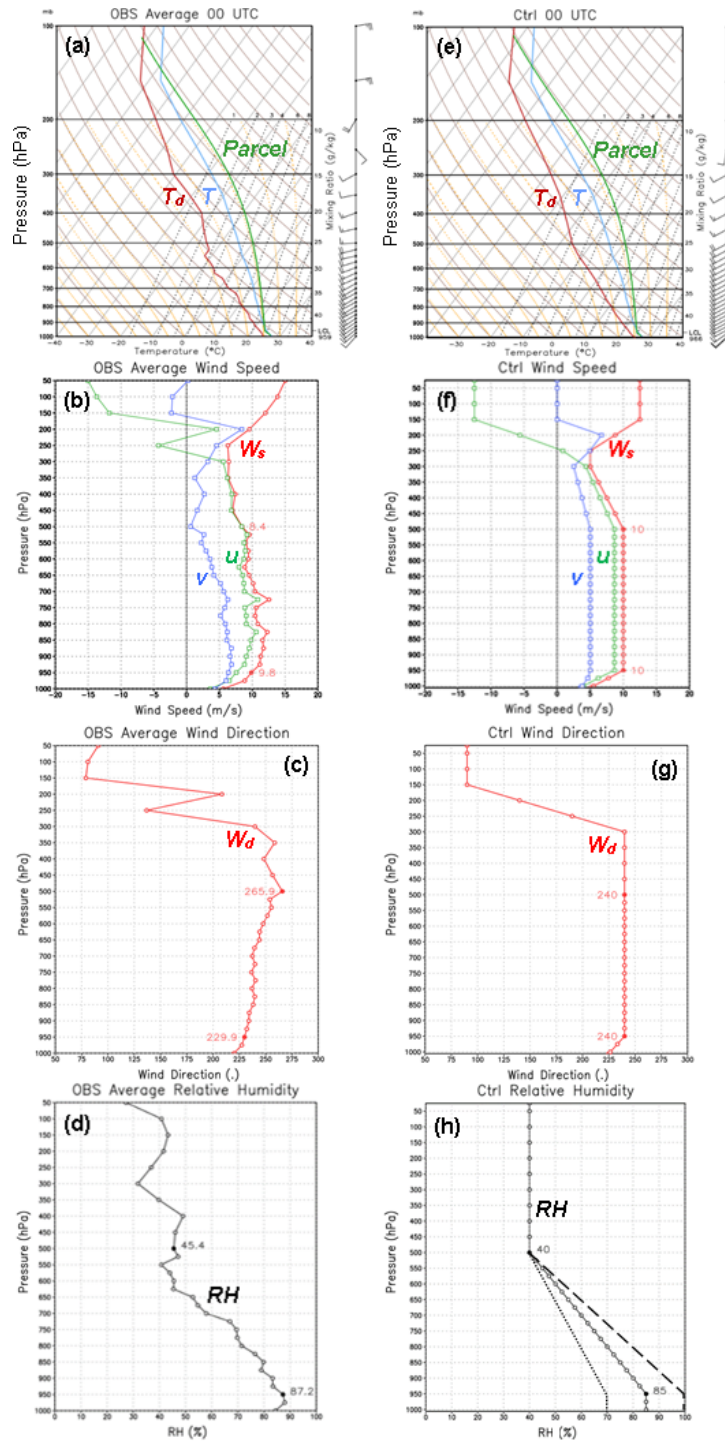
Figure 3. Mean vertical profiles of (a) temperature ( T , ◦ C), dew-point temperature ( T d , ◦ C), and wind (kt), together with the process curve for a surface parcel (following dry/moist adiabatic motion) in the Skew T -log p diagram, and horizontal wind (ms − 1 ), including (b) u and v components and wind speed ( W s , all in ms − 1 ), (c) wind direction ( W d , ◦ ), and (d) relative humidity (RH, %) from seven soundings taken at Dong-Sha Island and the research vessel (RV) upstream from Taiwan (see text for details). (e–h) As in (a–d) , except for the smoothed or prescribed profiles used in the CTL experiment (see text for details). In (h) , the long-dashed and dotted lines depict two other RH profiles used in moisture tests, with RH = 100% and 70% below 950hPa, respectively (no difference from CTL at and above